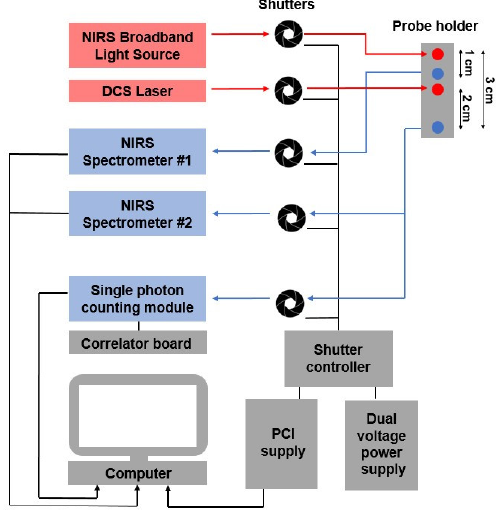
Figure 1. Schematic of the hsNIRS/DCS system and optical probe holder. Continuous arterial blood pressure was measured by finger photoplethysmography (Finometer, Finapres Medical Systems, Enschede, Netherlands), which was calibrated against three manual measurements for the sphygmomanometric brachial artery. Arterial blood pressure was used to calculate mean arterial pressure